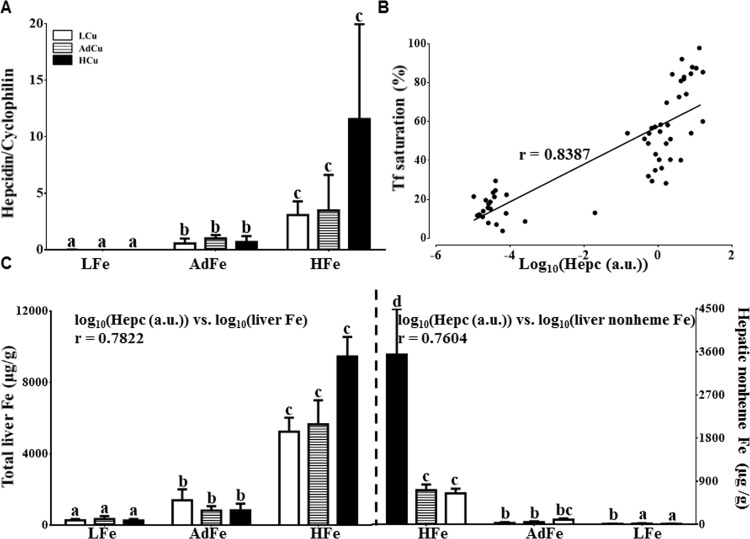
Extra copper in the HFe diets did not influence Hepc mRNA expression but it accentuated hepatic nonheme iron loading.Hepc mRNA expression was quantified in experimental rats (A), and the relationship between Hepc mRNA expression (log10) and Tf saturation was estimated by calculating Pearson product-moment correlation (B). The line of best fit is shown along with the correlation coefficient (r) (p<0.0001). Hepatic total (C, left side) and nonheme (C, right side) iron was also measured. Note that the 2 halves of panel C are mirror images with respect to the order of the experimental groups. Correlations were also calculated between Hepc mRNA expression (log10) and liver iron levels (log10) (r values are shown as insets) (C). Labeled means without a common letter differ (p<0.05). Values are means ± SDs. n values and abbreviations used are the same as in Fig 1. Data for Hepc mRNA and hepatic total and nonheme iron concentrations were log10 transformed prior to running statistical analysis due to large variations in values. For ease of interpretation, we have, however, presented the non-transformed data in the figure. a.u., arbitrary units. 2-way ANOVA factor analysis results are as follows: Hepc (Fe: p<0.0001; Cu: ns; Fe X Cu: p<0.001); total liver iron (Fe: p<0.0001; Cu: ns; Fe X Cu: p<0.01); and hepatic nonheme iron (Fe: p<0.0001; Cu: p<0.01; Fe X Cu: p<0.01). ns, not significant.